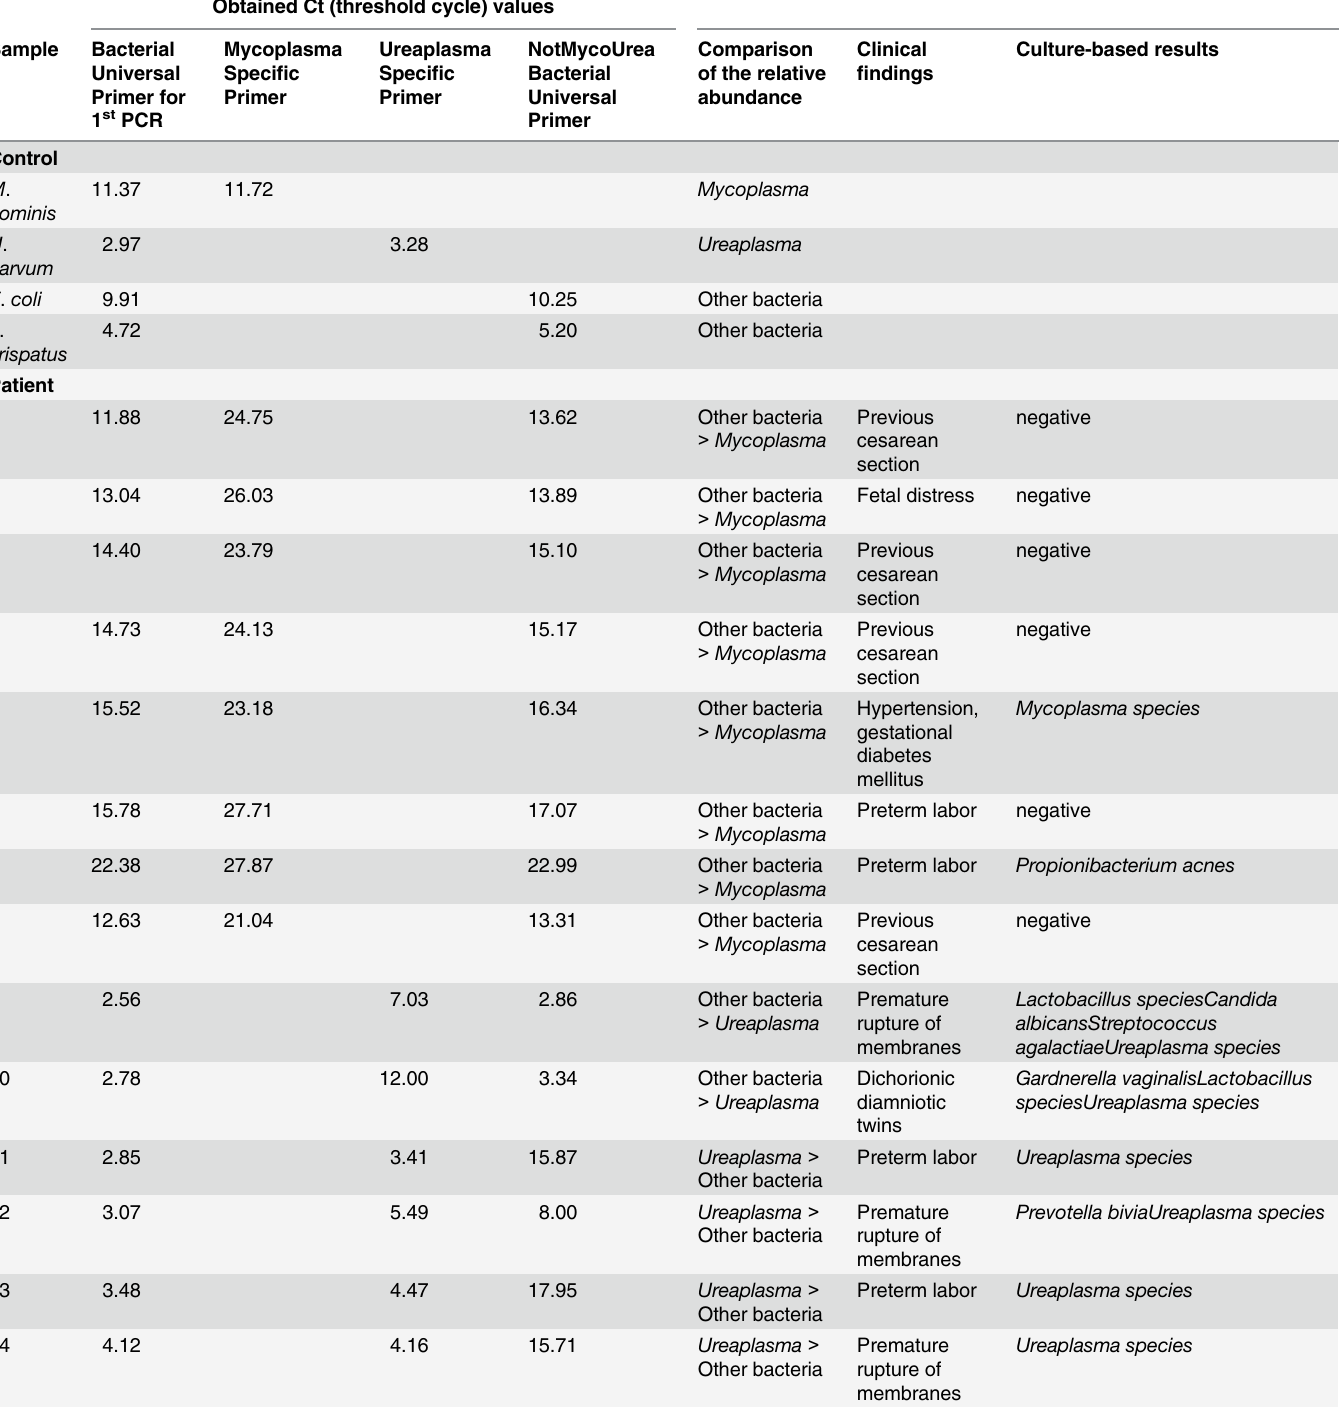
Table 3. The results of a comparison of the relative abundance of Mycoplasma , Ureaplasma , and/or other bacteria in amniotic fluid samples with mixed infection. Obtained Ct (threshold cycle) values